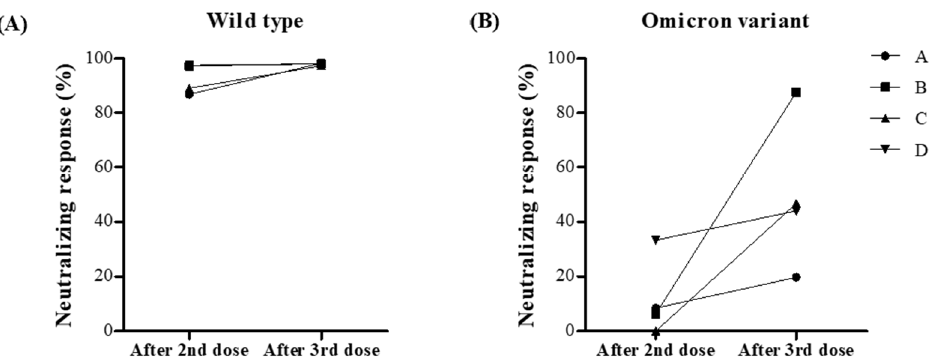
Figure 3. Neutralizing responses against the wild type and omicron variants of SARS-CoV-2 according to number of COVID-19 vaccinations (at median 99 and 57 days after a second and third COVID- 19 vaccination, respectively) in four people living with HIV (PLWH). ( A ) Changes of neutralizing responses against the wild type SARS-CoV-2 after the second and third vaccination, ( B ) Changes of neutralizing responses against omicron variant of SARS-CoV-2 after the second and third vaccina- tion.